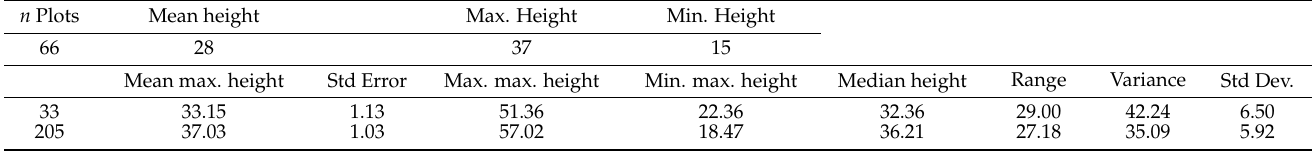
Table 5. RE 12.11.3 mean, maximum, and minimum canopy heights from 66 CORVEG plots [53] compared with maximum heights obtained from the 33 CORVEG plots available to ALS, and these 33 plots were compared to the 205 ALS virtual plots within the Southeast Queensland Bioregion (SEQ), randomly sampled from six identified subregional areas within SEQ. Height differences were not significantly different (Welch’s t -test, df = 46.66, F = 1.205, p = 0.057). All measurements are in metres. Max- = maximum, Min. = minimum, Std = standard, Std Dev. = standard deviation. n Plots Mean